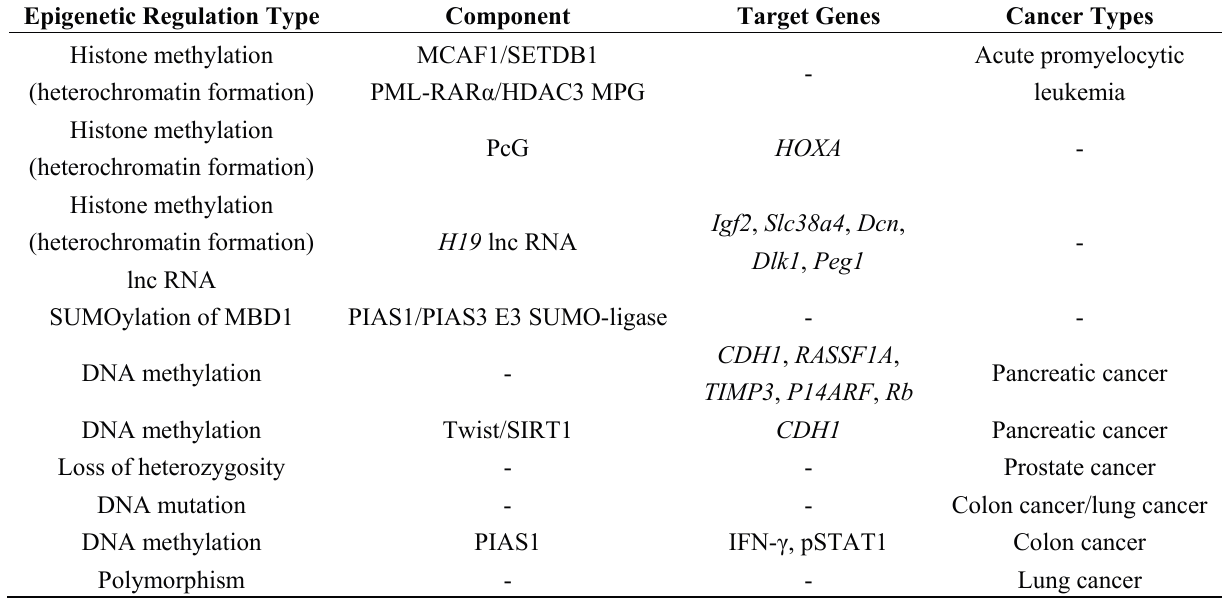
Table 1. Regulatory mechanisms and cancer types related to